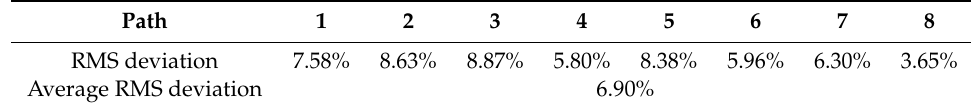
Figure 7. Average flow velocities along the eight paths determined through the ultrasonic transit-time method, showing a strong correlation between measurement and reference results. Table 1. Root-mean-square (RMS) deviations of the measured flow velocities from the reference velocities through eight paths of ultrasound